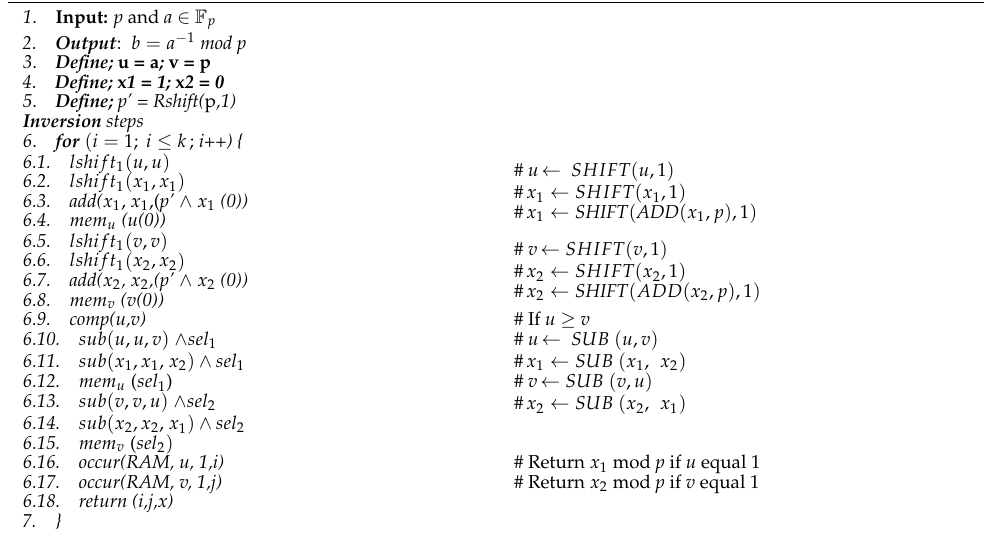
Algorithm 2: Pseudo-code of the proposed modified BEE